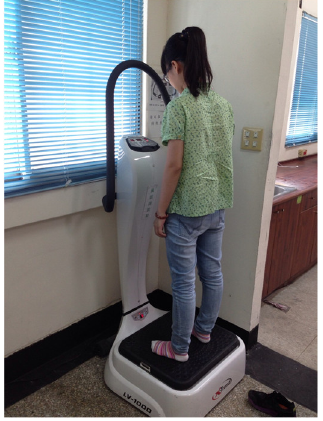
Int. J. Environ. Res. Public Health 2023 , 20 , x FOR PEER REVIEW Figure 1. A participant standing on the WBV machine. Figure 1. A participant standing on the WBV machine.